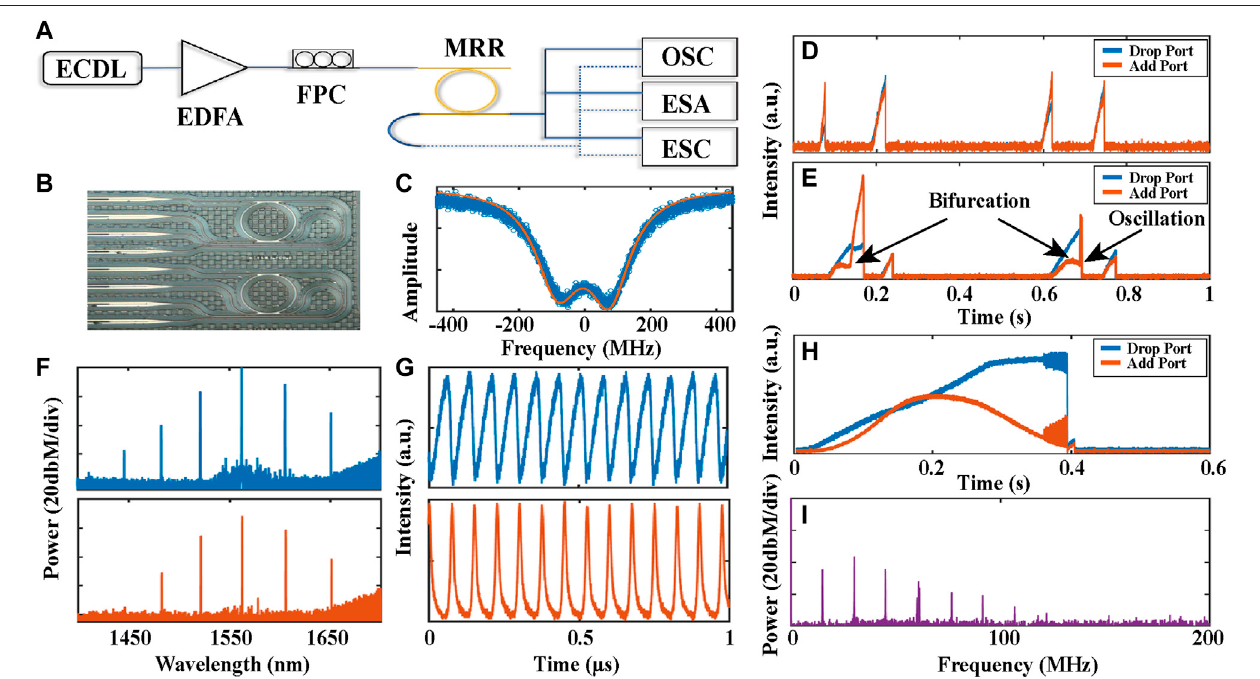
FIGURE2| Experimentaldemonstrationofspontaneoussymmetrybreakinginducedself-oscillationcascadeFWMinamicro-ringresonatorwithFSRof200G. (A) Experimentalsetup.Anexternalcavitydiodelaser(ECDL)isemployedtopumpamicro-ringresonator(MRR),andtheoutputlightsfromthedropport(CW)andaddport (CCW) are monitored by an optical spectrum analyzer (OSA), an electrical spectrum analyzer (ESA), and an oscilloscope (OSC), respectively. EDFA: Erbium-doped fi ber ampli fi cation, FPC: fi ber polarization control. (B) Imageof the MRR with a free spectral range of 200 GHz. (C) Transmission trace of aresonance that is split due to strong Rayleigh backward scattering. The Q-factor is ~ 1.2×10 6 . (D,E) Measured transmission traces with on-chip power of 150 and 800 mW, respectively. Using low pump power, the CCW light is almost linearly increasing with the CW light. For a higher pump power ( > 500 mW), nonlinear coupling between the CW and CCW lights dominates the transmission character, which induces bifurcation and power oscillation. (F) Measured optical spectra ofprimary comb from drop port(top) and add port (bottom), respectively. (G) Measured waveforms of the CW and CCW microcombs showing the oscillation of the primary comb. The two waveforms are antiphase inducedbytheself-switchingeffectinthemicro-cavity. (H) Powertraceswhile thepumplasersweepsacrossaresonance. Anobviousbifurcationisobservedwhenthe pump coupled into the resonance and power oscillation is formed at cascade FWM state. (I) Radio-frequency spectra of the self-oscillation cascade FWM